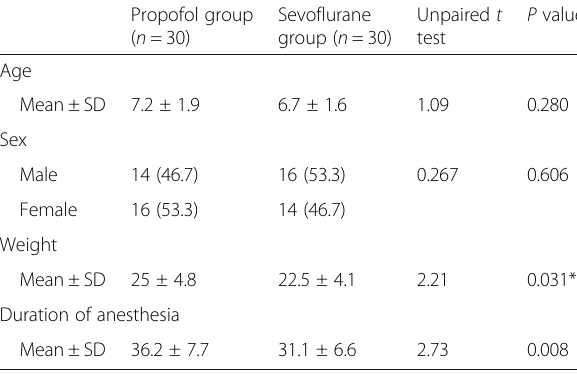
* P <0.05, statistically significant